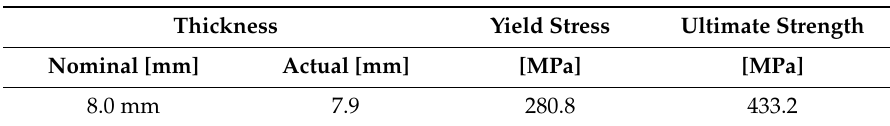
Table 5. Tensile test results.